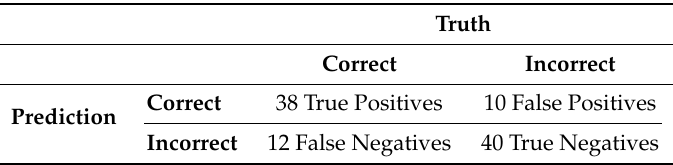
Table 4. Confusion Matrix for the Move Body feedback.